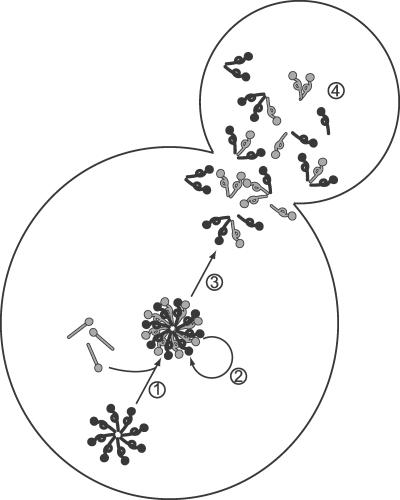
The In Vivo Prion Cycle Is a Multistep PathwayExisting prion complexes (black ball and loop) replicate by stimulating the conversion of either newly synthesized or non-prion conformer of the protein (gray ball and stick) to the prion form (black and gray ball and loop, step 1). Prion complexes must be stably maintained (step 2), but continually divided to generate new prion templates for additional rounds of protein-state replication (step 3). The smaller complexes generated by this division are efficiently transmitted to daughter cells (step 4).